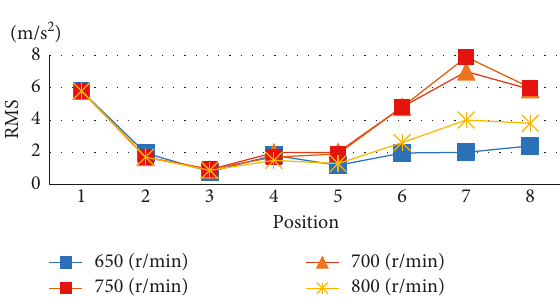
Figure 12: RMS of vibration extracted from each measuring point on the steering wheel-associated vibration path.